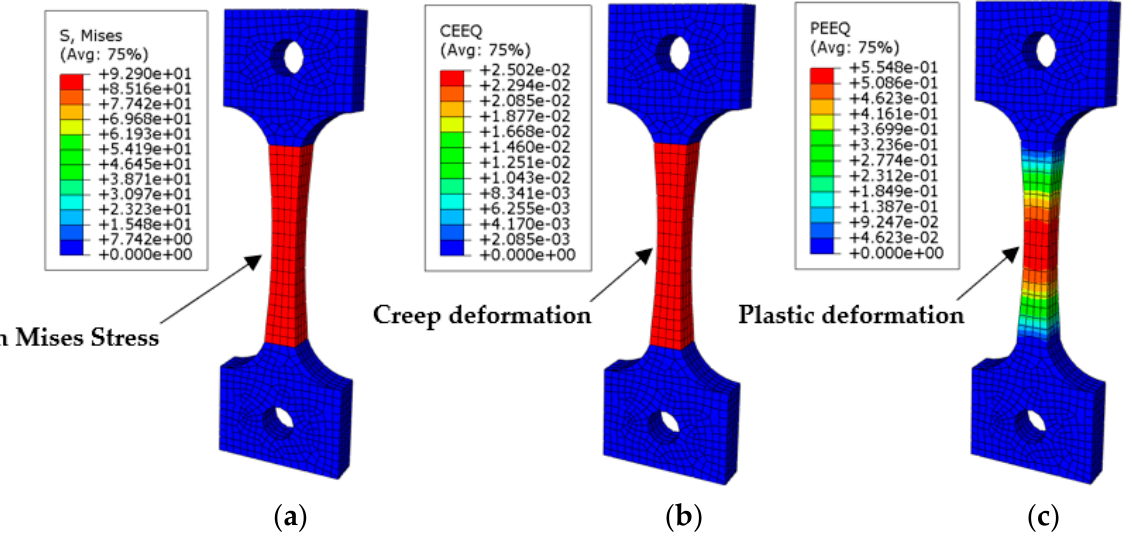
Figure 6. ( a ) Induced Von Mises stress in the specimen after running simulation; ( b ) creep strain (CEEQ) for the applied stresses, and ( c ) plastic strain (PEEQ) at 720 °C and 60 MPa.